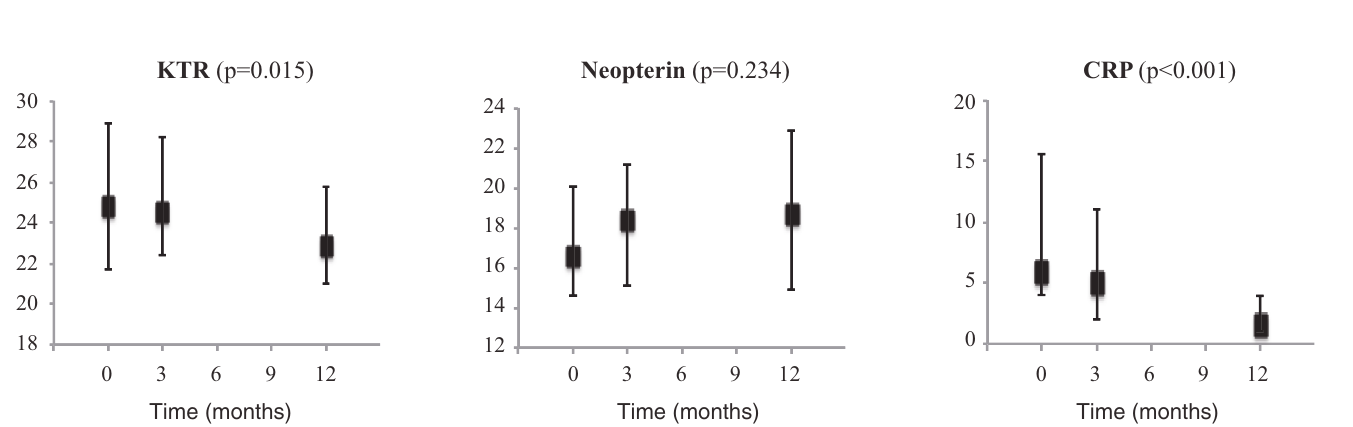
Fig 3. Inflammatory markers after bariatric surgery. Samples were measured at baseline, 3 months and after one year in 37 patients undergoing bariatric surgery. P values for trend over time are estimated with a random intercept mixed model, adjusted for type of operation and vitamin B supplementation. Data are given as median (25th to 27th